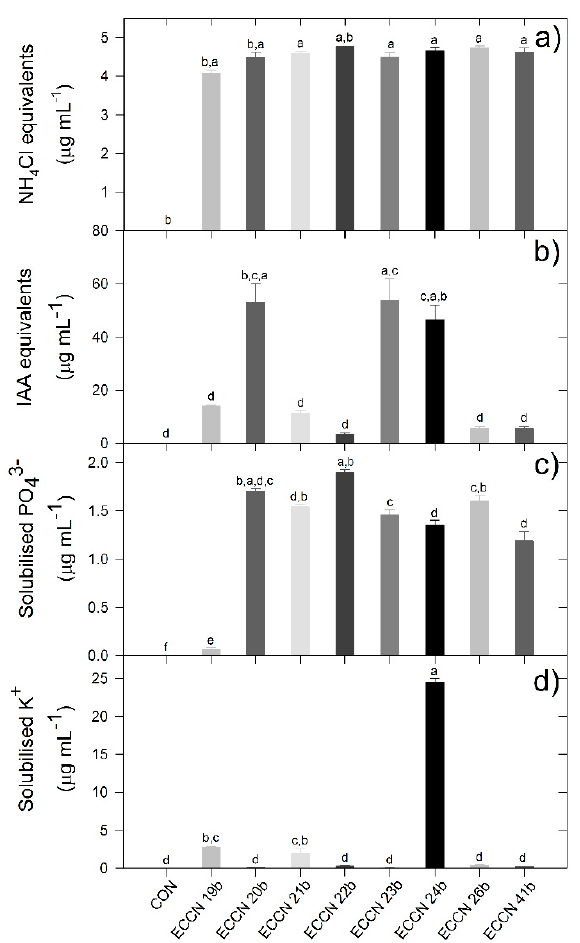
Figure 2. Screening of coal-degrading bacterial isolates for plant growth-promoting characteristics. Estimates of ammonium production ( a ), indole production ( b ), phosphate ( c ) and potassium solubilisation ( d ) by these bacterial isolates in stationary phase (OD600 = 0.4 at 30 °C) were determined spectrophotometrically. Results are expressed as the mean ± S.E. Means denoted by a different letter indicate significant differences relative to a negative control ( p < 0.05).